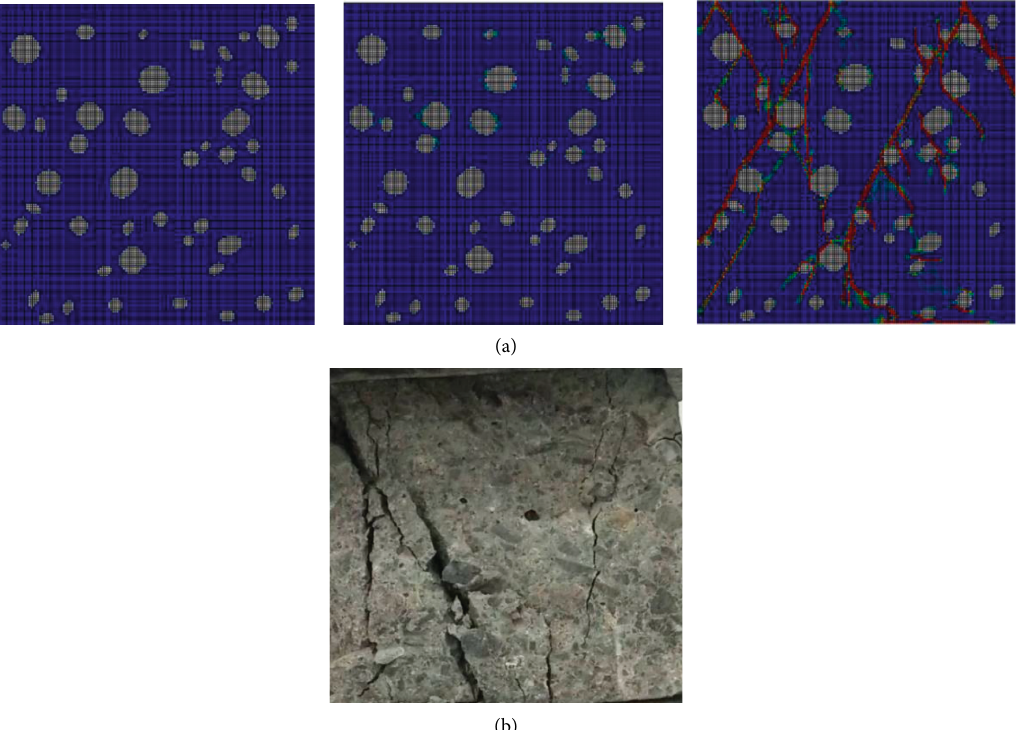
Figure 11: Failure morphology of RCA-100% cube under compression. (a) Simulation diagram of cubic compression fracture extension. (b) Test diagram of cubic compression fracture